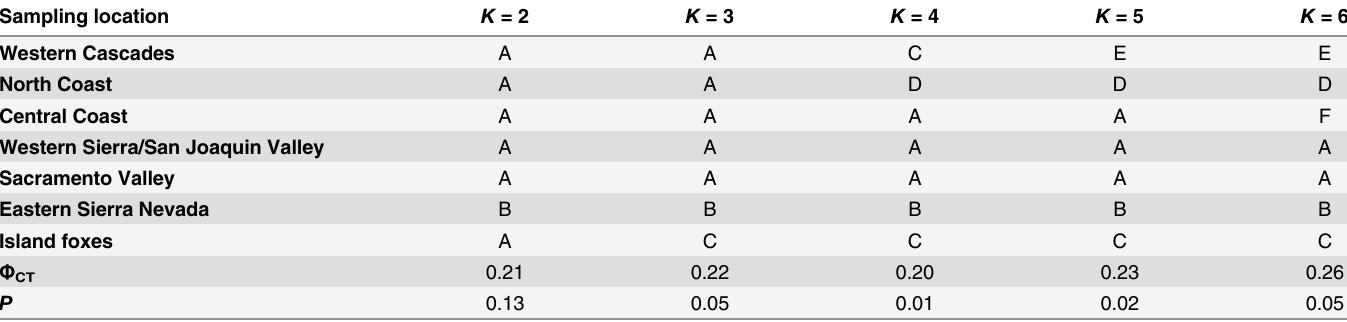
Table 3. Best population groupings for K = 2 – 6 for combined cytochrome b and D loop sequences and statistical results from SAMOVA. Sampling